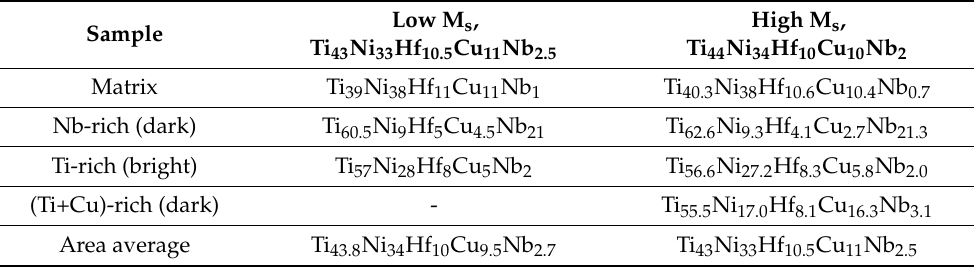
Table 2. Chemical composition in Ti 43 Ni 33 Hf 10.5 Cu 11 Nb 2.5 and Ti 44 Ni 34 Hf 10 Cu 10 Nb 2 samples anal- ysed by